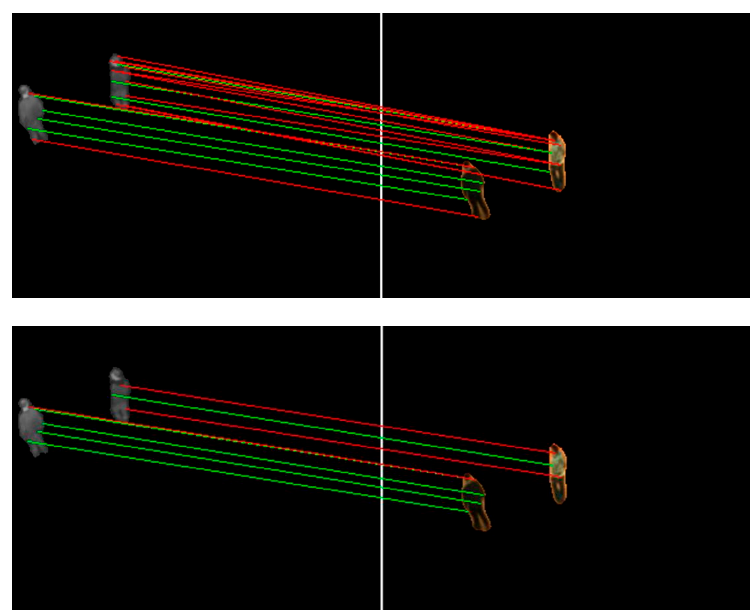
Figure 6. Matched keypoint pairs obtained before using the elimination of mismatches (the upper) and after using the elimination (the lower). The red lines represent mismatches and the green the correct matches.